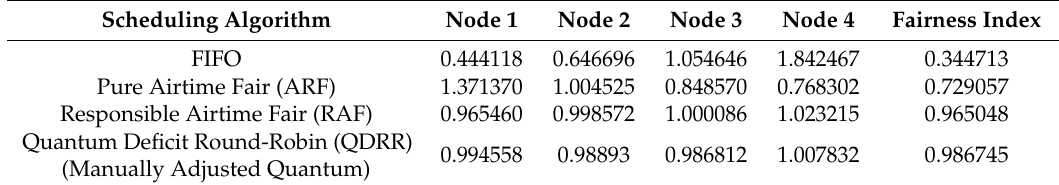
Table 4. Throughput Achieving Ratio and Fairness Index in TCP Traffic.